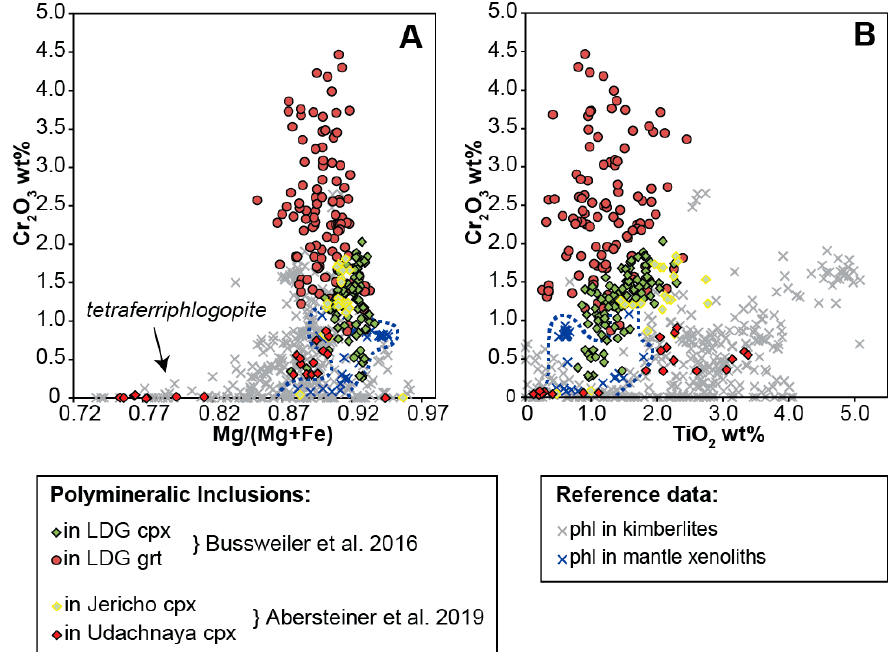
Figure 3. Compositional variation of phlogopite ( A : Cr 2 O 3 versus Mg / (Mg + Fe), B : Cr 2 O 3 versus TiO 2 ) within polymineralic inclusions in clinopyroxene and garnet megacrysts from Lac de Gras (LDG) (modified after Bussweiler et al. [44]; their Figure 6), and clinopyroxene megacrysts from Jericho and Udachnaya [46]. Reference data for phlogopite in kimberlites are from Eccles et al. [65], Armstrong et al. [66], and Kopylova et al. [67]. Reference data for phlogopite in mantle xenoliths are from Menzies et al. [68] and Giuliani et al.